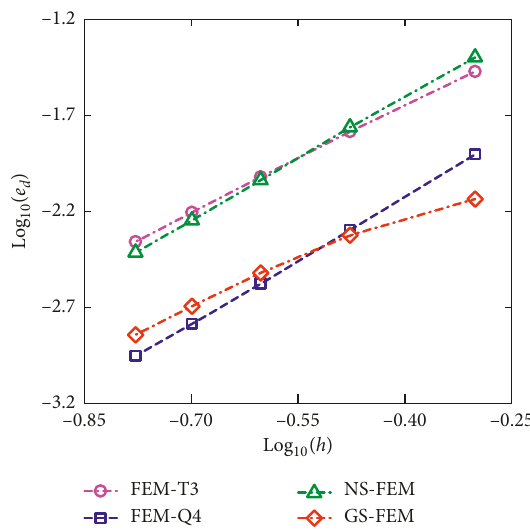
Figure 20: Convergence rate of displacement error